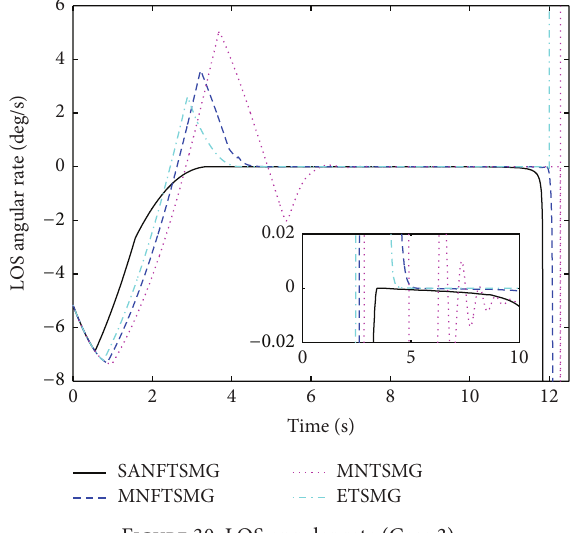
Figure 30: LOS angular rate (Case 3).